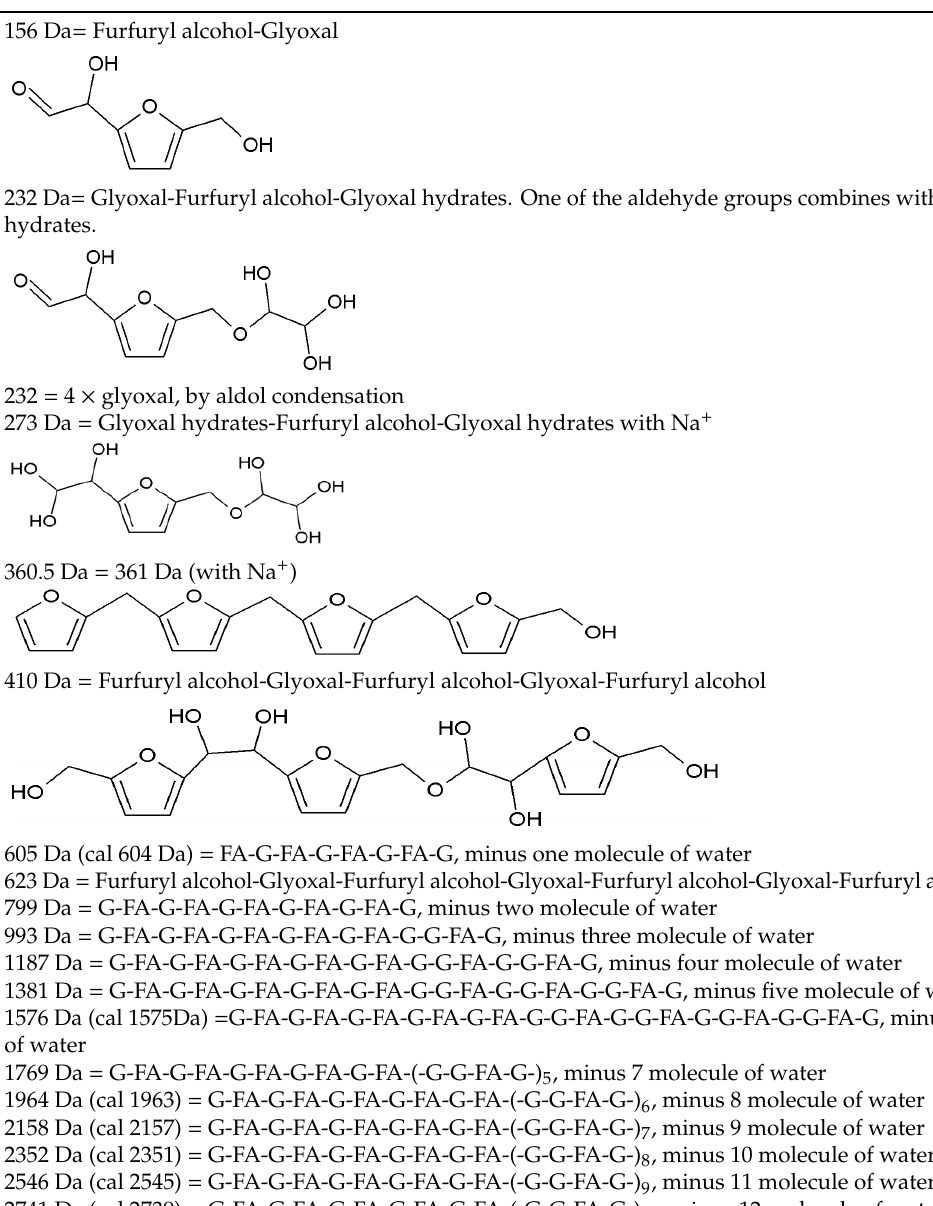
Table 3. Proposed oligomer structures for the MALDI ToF spectra peaks in Figure 8 for the furanic-glyoxal foams.